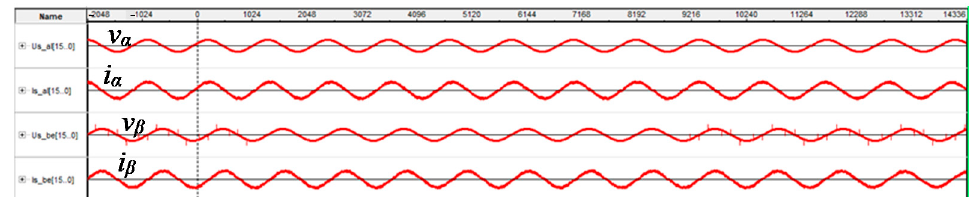
Figure 16. Phase modulation of grid voltages (from − 30° to +30° within 100 ms interval) at constant active component 0.7 P N .